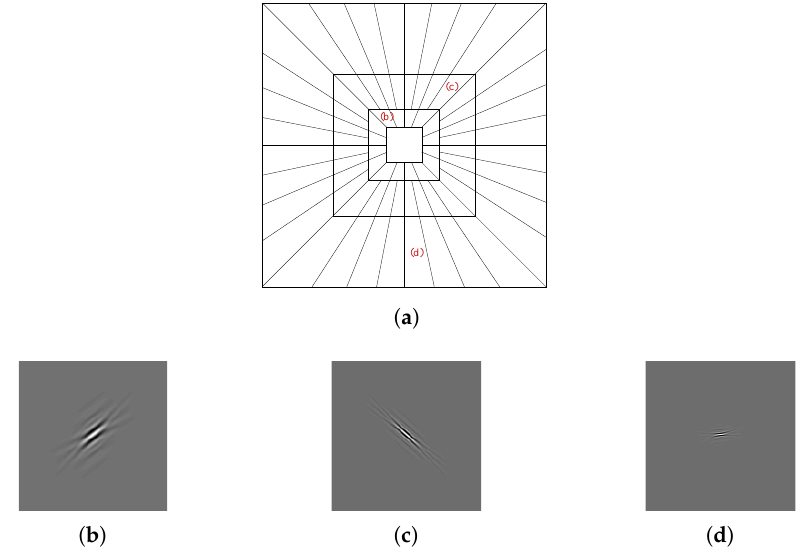
Figure 3. Curvelet in the frequency and spatial domain. ( a ) Curvelet tiling of the frequency domain; ( b – d ) Curvelets for various scales and directions in the spatial domain. Curvelets are drawn on k 1 = w /2 and k 2 = h